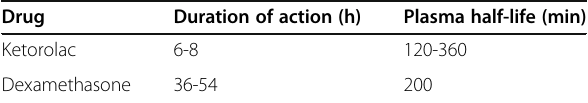
Table 4 Comparison of ketrolac and dexamethasone